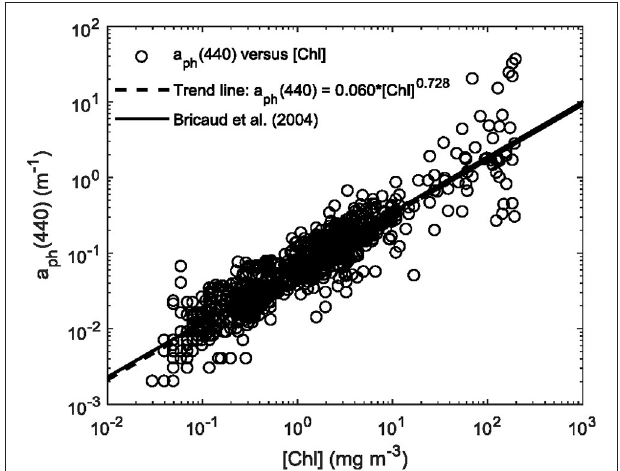
The trend line is also shown in comparison to that by Bricaud et al. (2004).